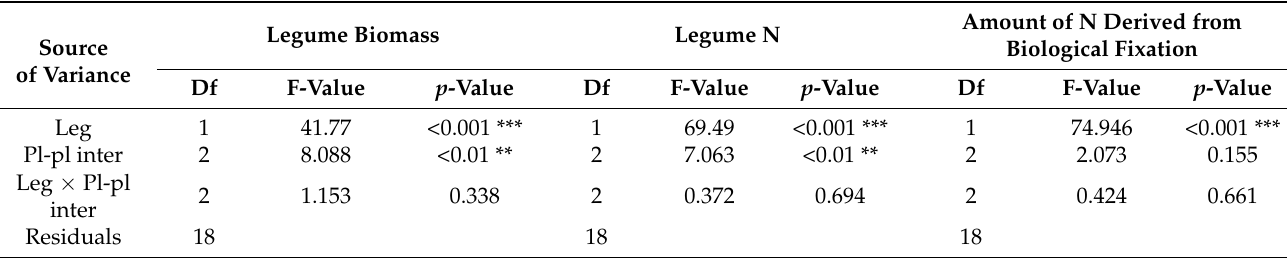
Table 1. Effect of legume choice (Leg) and plant-plant interaction (Pl-pl inter)—analysis of variance. Source of